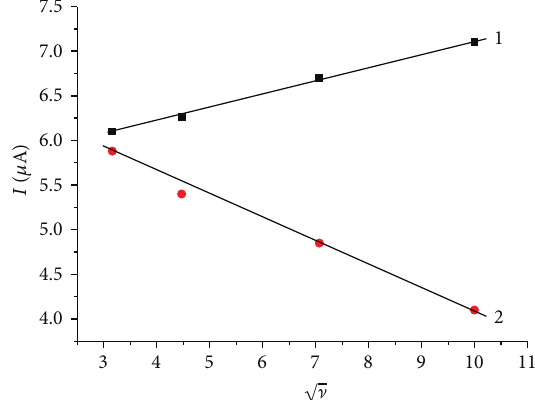
Figure 3: The dependence of peak currents on square root of scan rate. All experimental conditions as in Figure 2. (1) Reduction peak currents, (2) oxidation peak